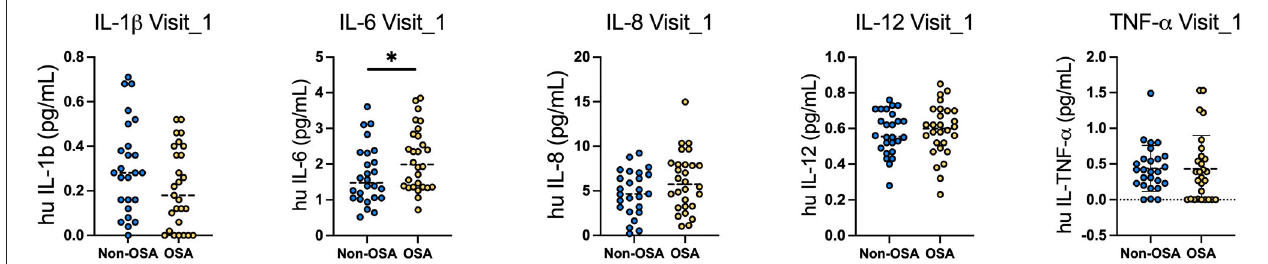
FIGURE 2 | Levels of circulating cytokines in OSA and non-OSA patient groups at 4-months and 12-months after COVID-19 infection. Circulating levels of IL1b, IL-6, IL-8, IL-12 and TNF-a were measured in the serum of OSA and non-OSA at 4-months (Visit_1) and 12-months (Visit_2) after COVID-19 infection. Mann Whitney tests were used to analyze each cytokine and * p = 0.04.